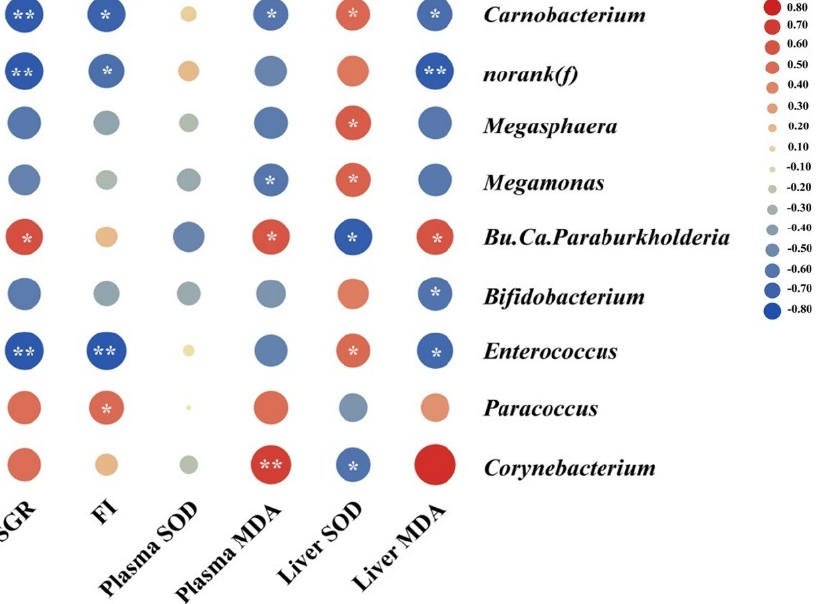
Figure 8. The Pearson correlation between gut microbiota and biomarkers. Circles in the balloon plot denoting the direction of the association are colored red (positive) or blue (negative) and overlaid with the symbol “*” indicating a significant correlation. Values marked with white symbol “*” are significantly correlation ( p < 0.05), and “**” are very significantly correlation ( p < 0.01).